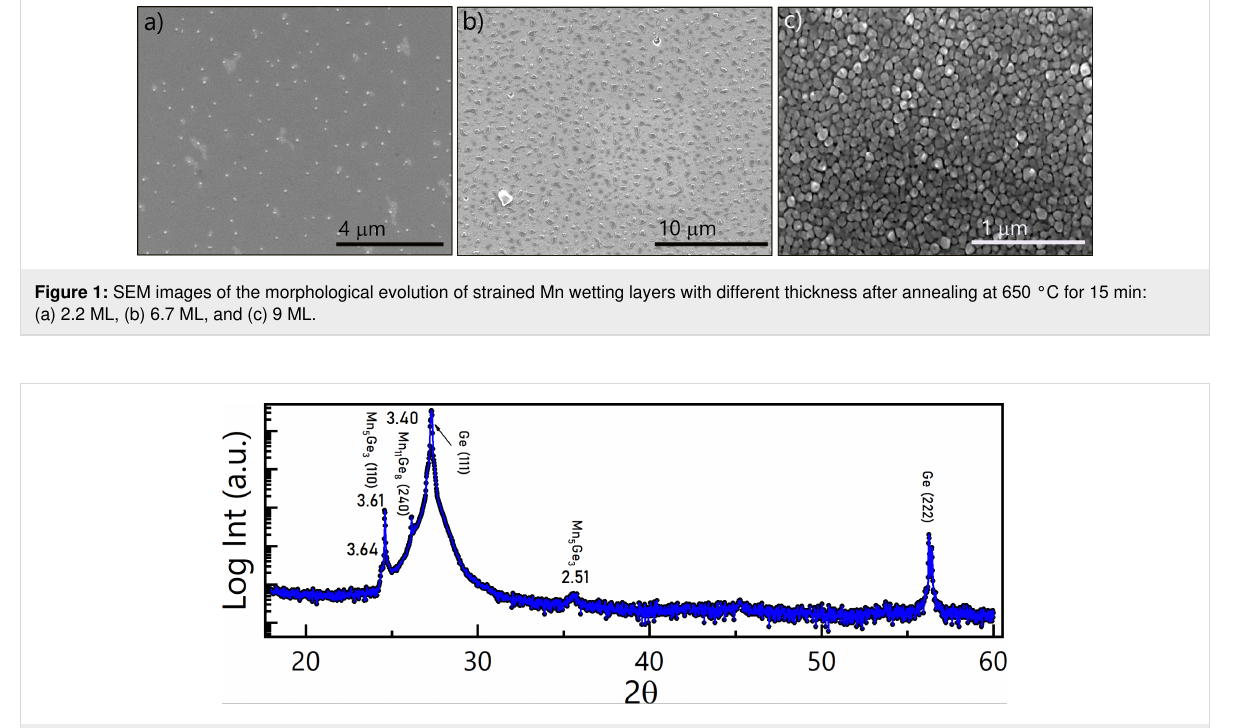
Figure 2: X-ray diffraction pattern of the 9 ML thick Mn wetting layer, upon annealing at 650 °C for 15 min. Both Mn 5 Ge 3 and Mn 11 Ge 8 phases have been detected, the former being